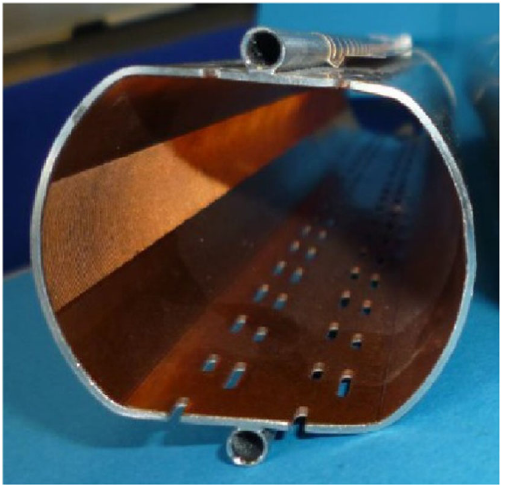
FIG. 2. Cross section of the LHC vacuum chamber